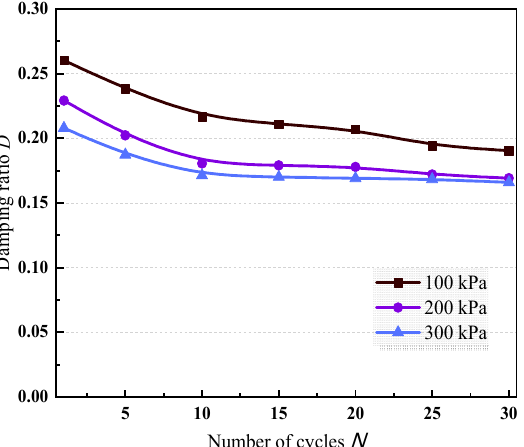
Figure 18. Damping ratio–cycle number curve under different normal stress conditions.